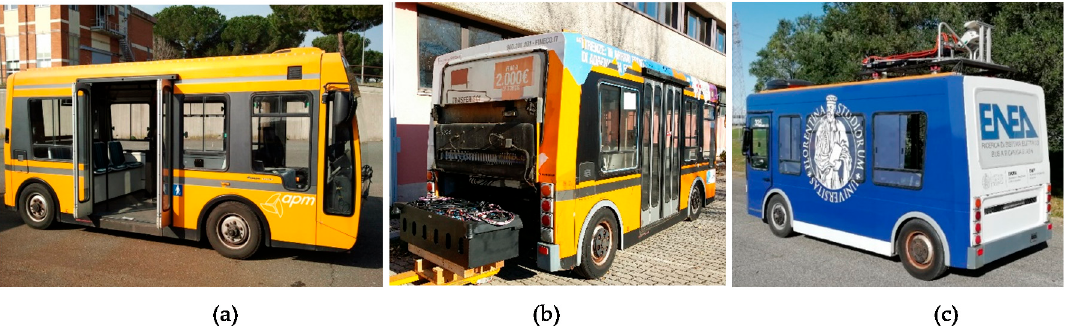
Figure 1. Project prototypes: P1 ( a ), P2 ( b ) and P3 ( c ).